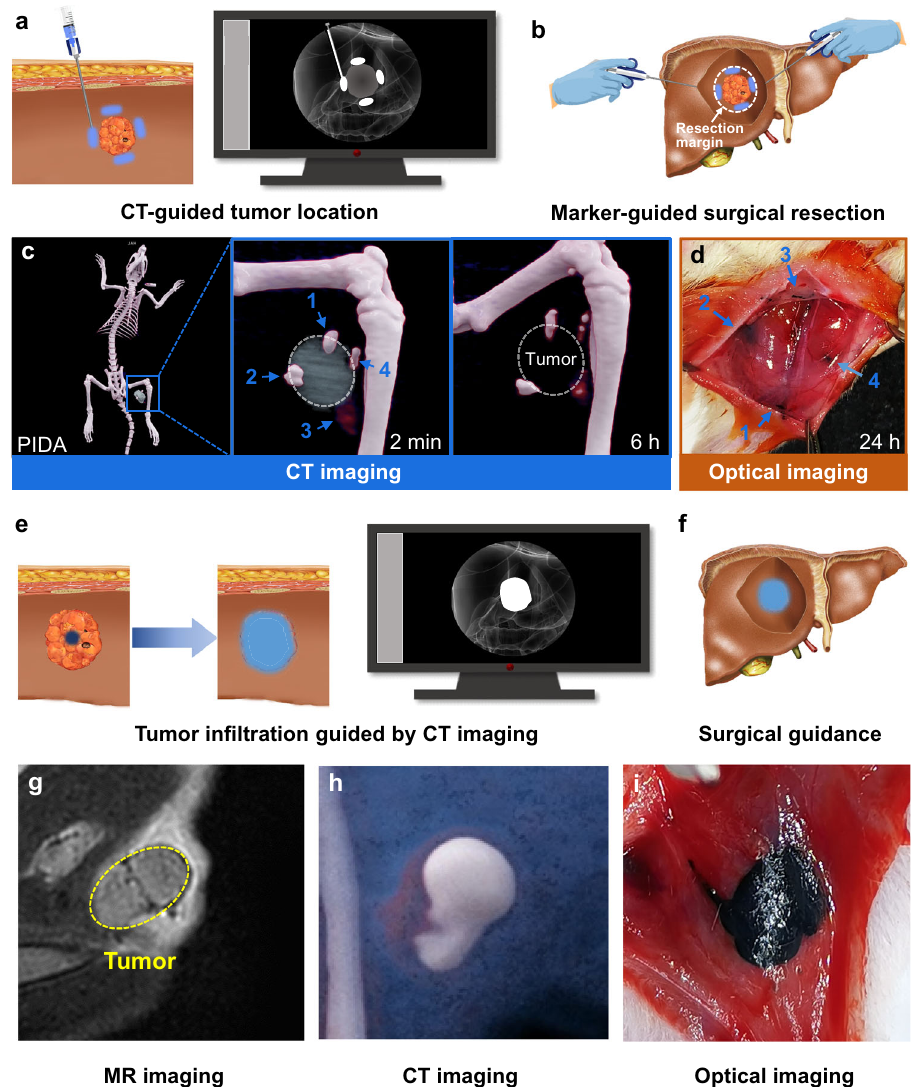
Fig. 3 CT-guided preoperative tumor labeling and visualization-guided surgery on basis of CT and eye dually visible PIDA. a , b Schematic illustration of tumor labeling by PIDA marker under CT guidance ( a ) and surgical resection of the labeled tumor guided by eye-visible blue PIDA ( b ). c CT images of a tumor-bearing rat injected with a PIDA suspension at 4 spots on the tumor periphery ([I]: 4 mg mL − 1 , 50 μ L each) over time. Tumors were omitted for better illustration for CT images of 6 h. d Exposed orthotopic tumor sites of the rat injected with PIDA. 4 blue PIDA residues surrounding the tumor clearly determined the resection margin of the tumor. e Schematic illustration of CT-guided tumor in fi ltration of intratumorally injected PIDA suspension. f Tumor in fi ltration of PIDA nano fi bers for tumor boundary determination. g – i Complete tumor in fi ltration of PIDA nano fi bers at 2 h post the injection measured by MR imaging ( g ), CT imaging ( h ), and optical imaging ( i